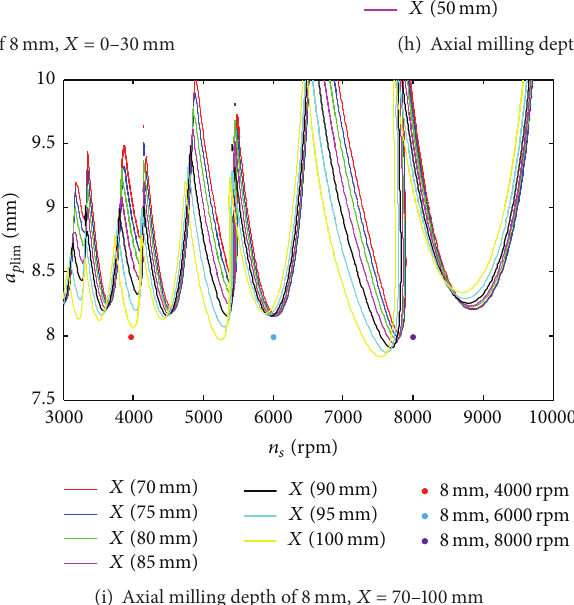
Figure 10: Dynamic SLD of milling process with the axial milling depth of 4 mm, 6mm, and 8 mm.